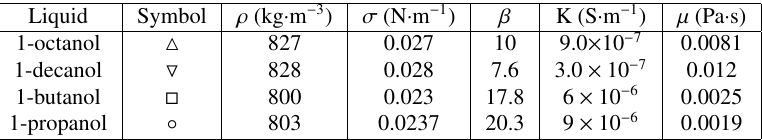
Table 1. Properties of the liquids used in the set of experimental series reported.